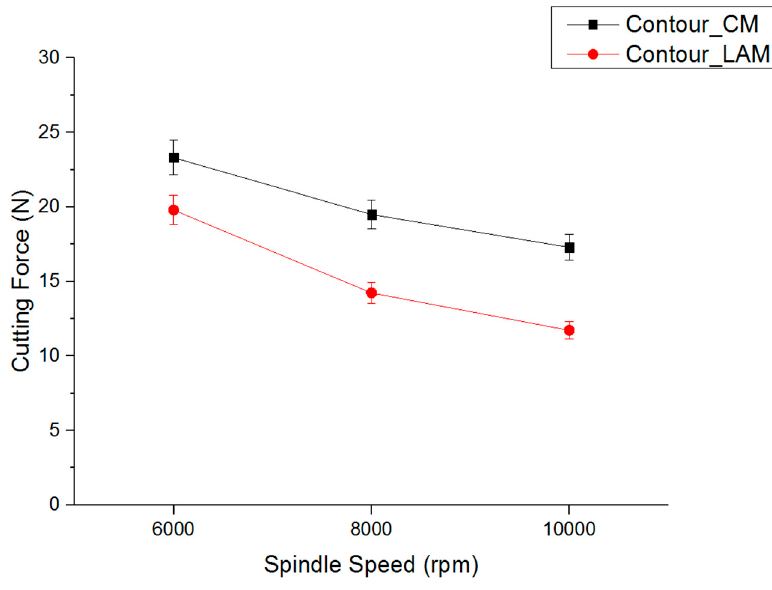
Figure 14. Experiment results by the feed rate 200 mm/min in contour milling.